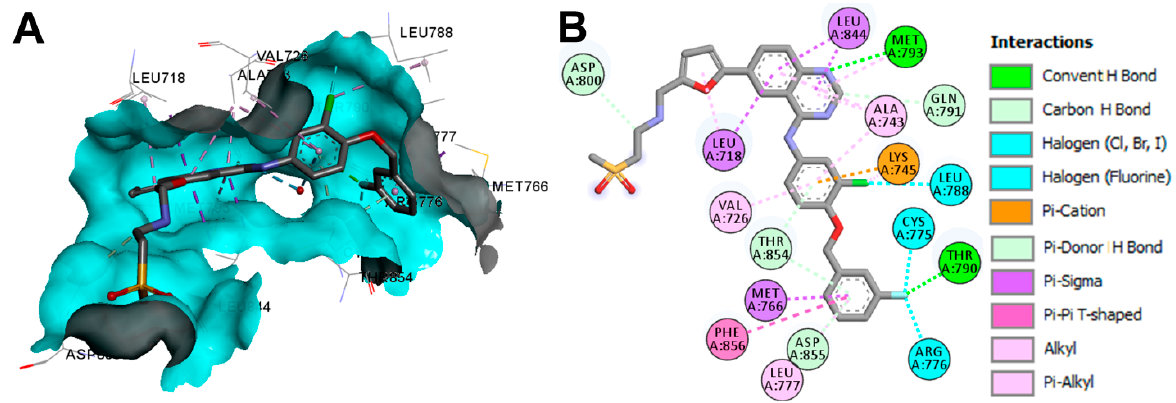
Figure 40. Kinases inhibitory activities of lapatinib. Figure 41. Binding modes of lapatinib (shown as sticks) into EGFR kinase domain (pdb: 1XKK): ( A ) 3D binding mode, receptor shown as hydrogen bond surface; ( B ) 2D binding mode showing different types of binding interactions; the figure was generated using Discovery Studio Visualizer (V16.1.0.15350).